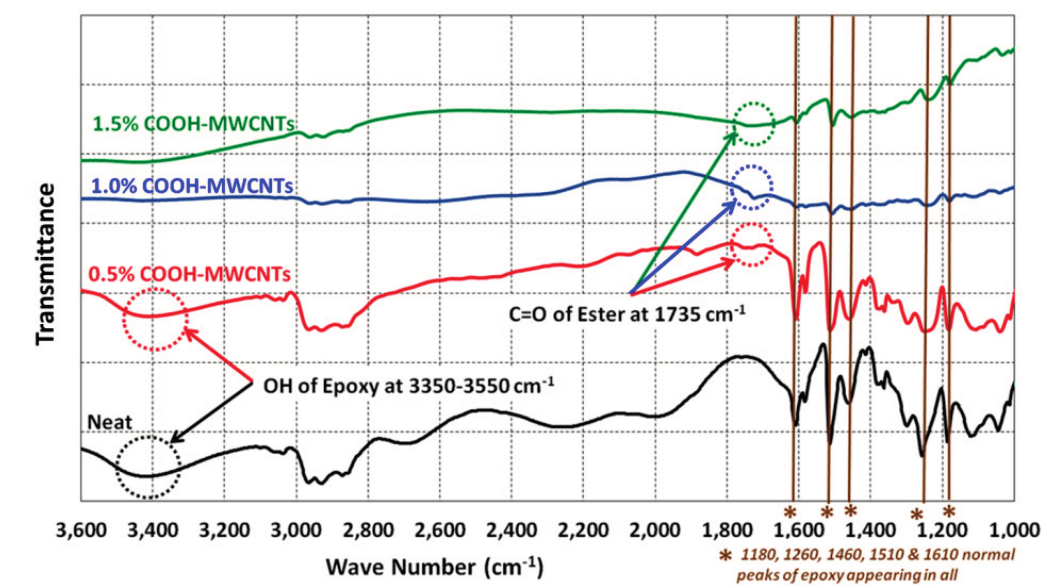
Figure 14. The peaks observed in the FTIR spectroscopy for samples of the four MWCNTs contents. The FTIR analysis shows that all epoxies with and without MWCNTs display the standard epoxy peaks observed at 1180, 1260, 1460, 1510, and 1610 cm − 1 . Epoxy incorporating 0.5 wt% and 1.0